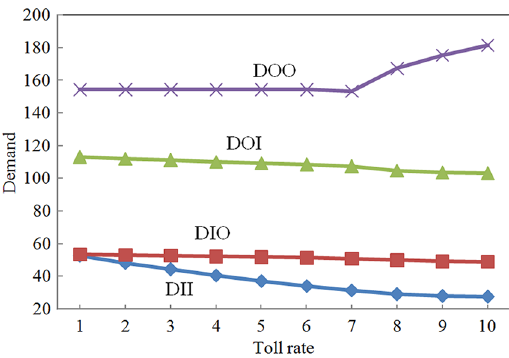
Fig. 3. Analysis of demand under area pricing